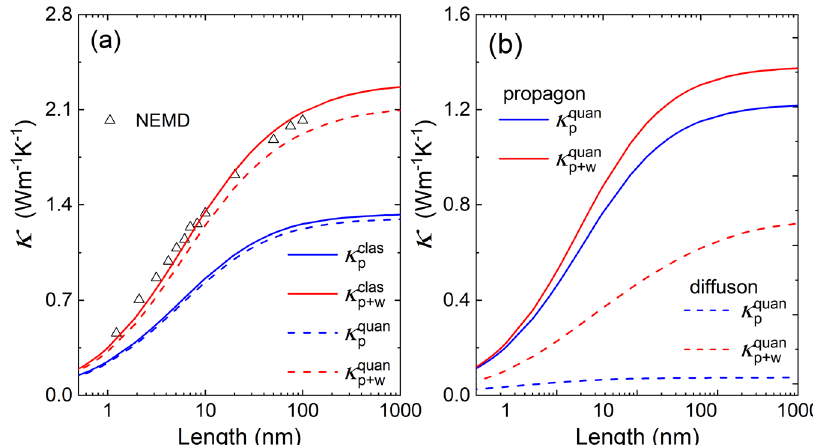
Fig. 6 Length-dependent thermal conductivity of amorphous silicon at 300 K. a Length-dependent classical and quantum thermal conductivity of amorphous silicon, respectively, from particlelike and wavelike contributions at 300 K. The symbols denote the results from non-equilibrium molecular dynamic (NEMD) simulations. b Length-dependent quantum thermal conductivity, respectively, from propagons and diffusons at 300